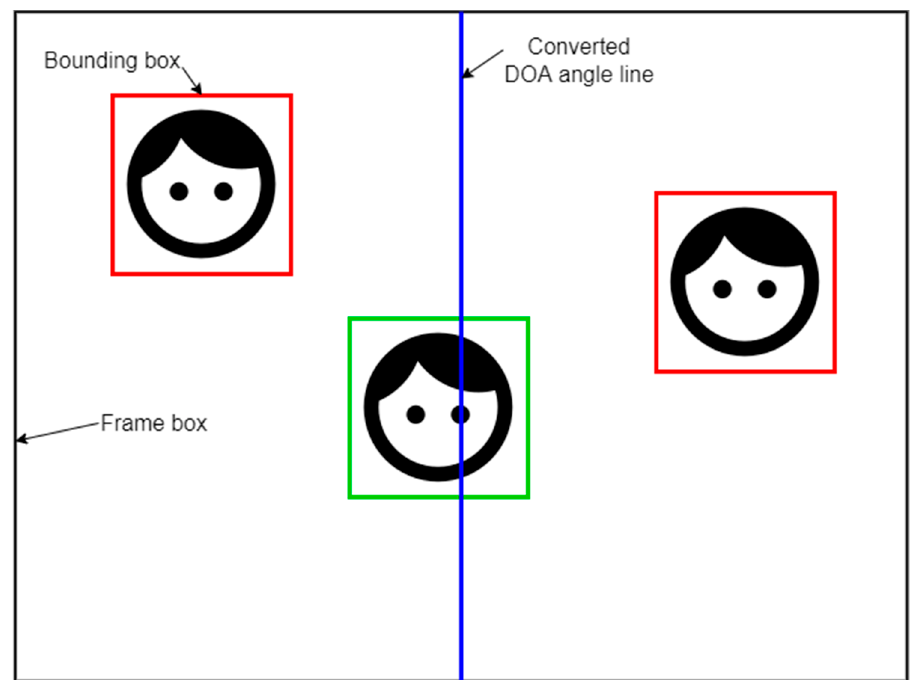
Figure 7. Face detection and attention focusing.